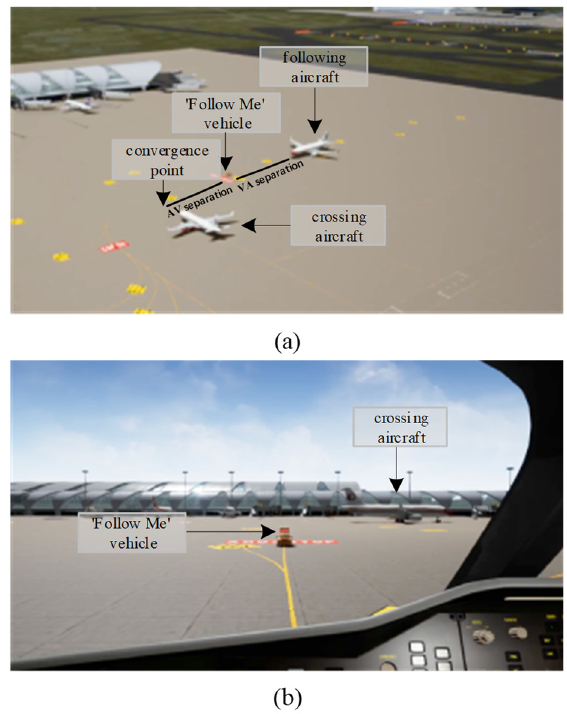
Figure 1. Simulation of Vehicle and Aircraft Convergence in the Intersection. ( a ) Before cross convergence; ( b ) After cross convergence.